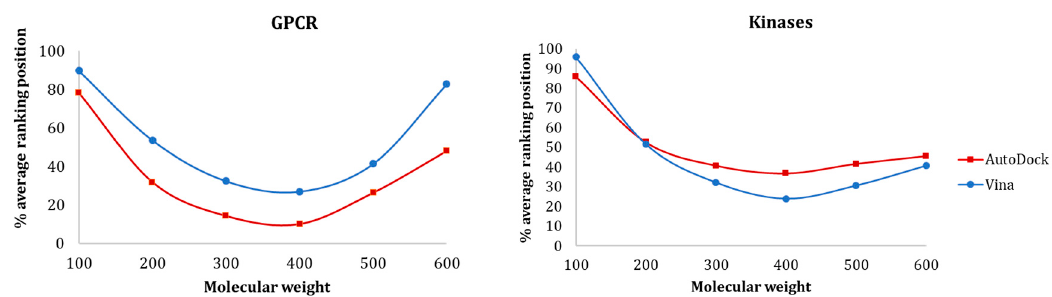
Figure8. InfluenceofMWon( a )GPCRand( b